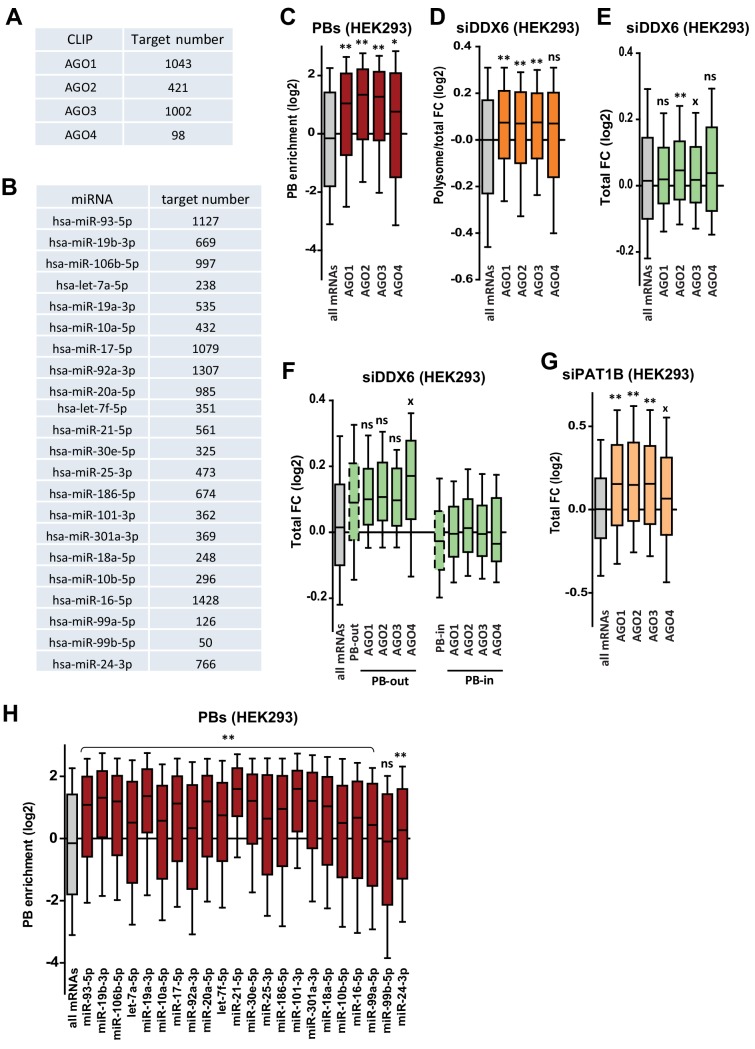
Targets of the miRNA pathway.(A,B) Number of AGO targets (A) and miRNA targets (B) analyzed in (C–H) and in Figure 5C,D. (C–E) AGO targets are enriched in PBs (C), translationally derepressed (D) and little or not stabilized (E) following DDX6 silencing. Two-tail Mann-Whitney test was performed with respect to all mRNAs. **, p<0.0001; *, p=0.002, x, p=0.04; ns, non-significant. (F) AGO targets excluded from PBs accumulate following DDX6 silencing like other PB-excluded transcripts. The analysis was performed as in Figure 5—figure supplement 2C. Two-tail Mann-Whitney test was performed with respect to cognate PB-out or PB-in mRNAs. x, p=0.04; ns, non-significant. (G) AGO targets accumulate following PAT1B silencing. Two-tail Mann-Whitney test was performed with respect to all mRNAs. **, p<0.0001; x, p=0.04. (H) The extent of PB enrichment of miRNA targets depends on the miRNA. Two-tail Mann-Whitney test was performed with respect to all mRNAs. **, p<0.0001; ns, non-significant.